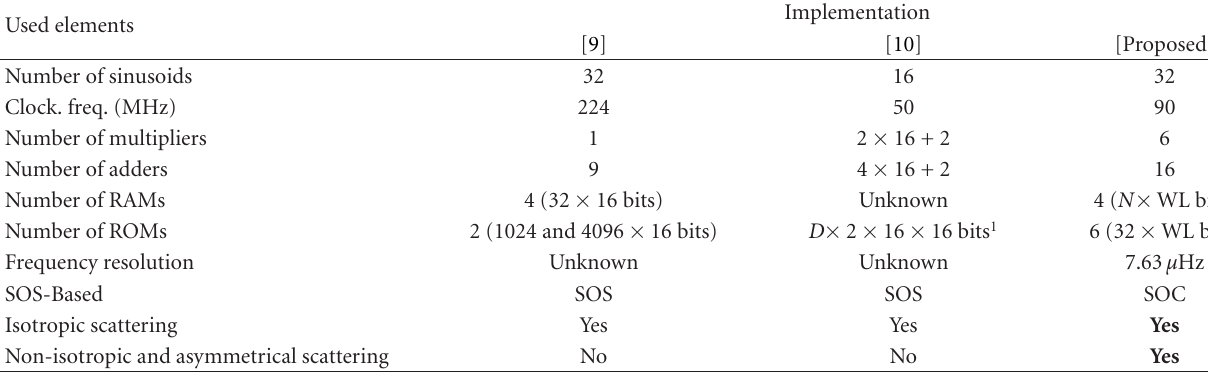
Table 2: Performance comparison of fading channel simulators (Rayleigh